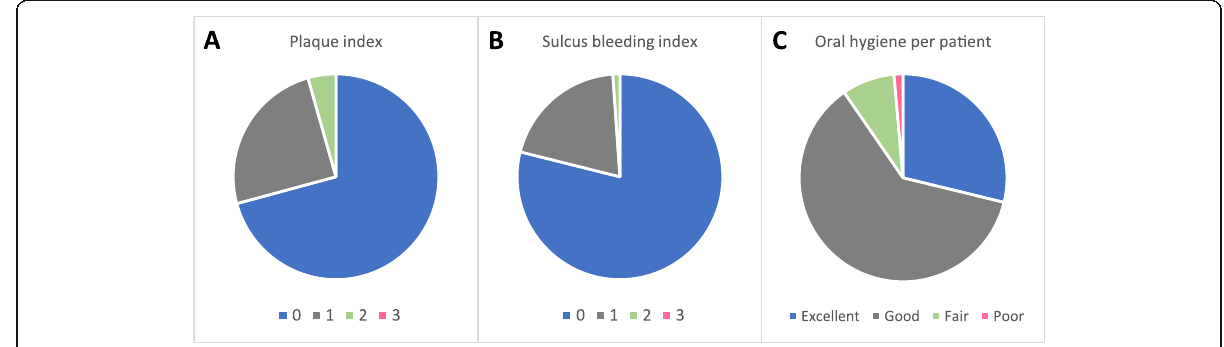
Fig. 4 Soft tissue parameters at 5-year post-loading. a Plaque index: score 0, no plaque detected; score 1, plaque only recognized by running a probe across the smooth marginal surface of the implant; score 2, plaque seen by the naked eye; score 3, abundance of soft matter. b Sulcus bleeding index: score 0, no bleeding when a periodontal probe was passed along the gingival margin adjacent to the implant; score 1, isolated bleeding spot visible; score 2, blood formed a confluent red line on margin; score 3, heavy or profuse bleeding. c Oral hygiene assessed per